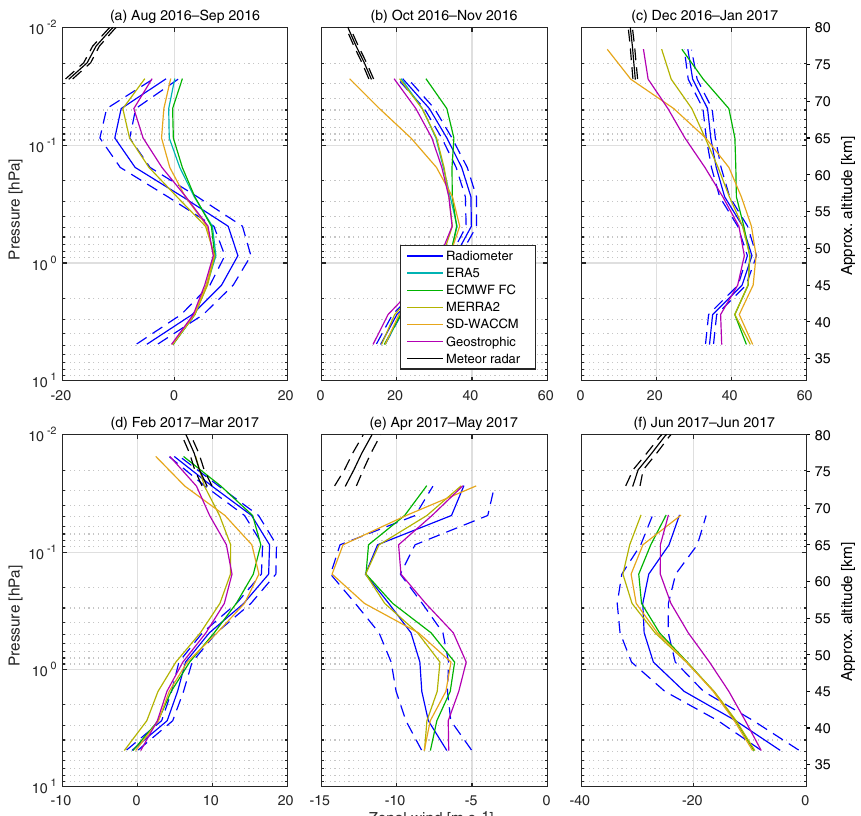
Figure 11. Bimonthly average profiles of zonal wind at Andenes from reanalyses and models convolved according to Eq. (2) in comparison with observations from the wind radiometer WIRA and its random error (dashed). ERA5 data were only available for the first two panels at the time of writing. At the uppermost altitudes the raw, i.e. unconvolved, meteor radar wind profiles are shown. Due to the temporal variations of the upper altitude limit of the radiometer observations visible in Figs. 9 and 10 the sampling period of the meteor radar average wind can be rather different from the highest levels of middle-atmospheric data especially for the summer half-year, i.e. in panels (a) , (e) and (f)